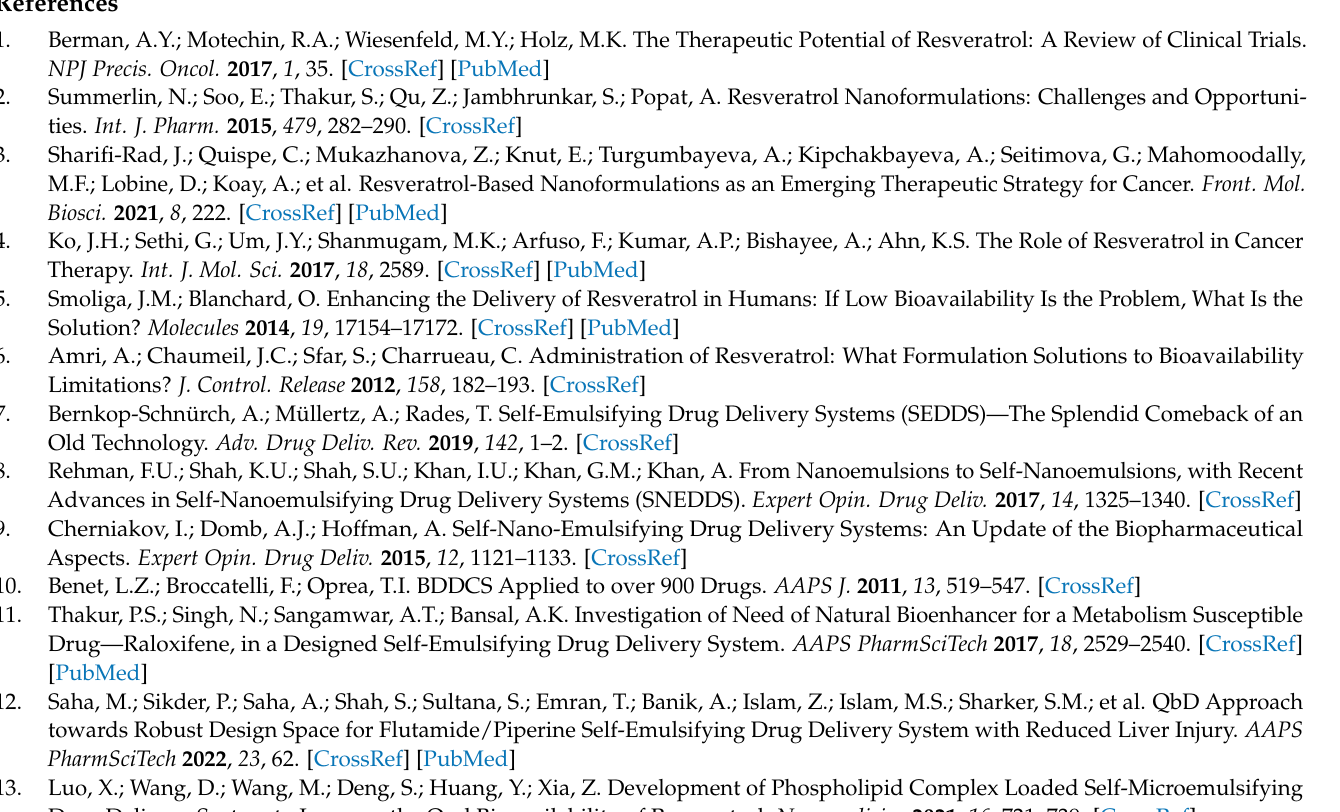
QAs; Table S1: Emulsification time and transmittance percentage of different concentrations of oil, surfactant, and co-surfactant, examined in 11 different points; Table S2: Emulsification time and transmittance percentage data of different concentrations of TPGS were examined at 7 points; Table S3: The polynomial model fitting summary of CQA responses; Table S4: The optimization criteria of CMAs and CQAs responses; Table S5: The verification points were shown as the weight ratio of oil, surfactant, and co-surfactant. Alongside, the CQA responses of the verification runs with their predicted mean and 95% prediction intervals were also